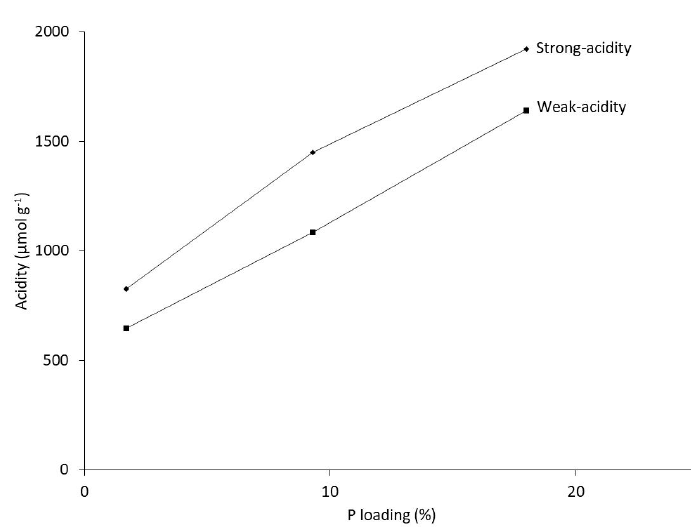
Figure 3. Variation in the acidity of P-ZSM-5_280 with P loading.